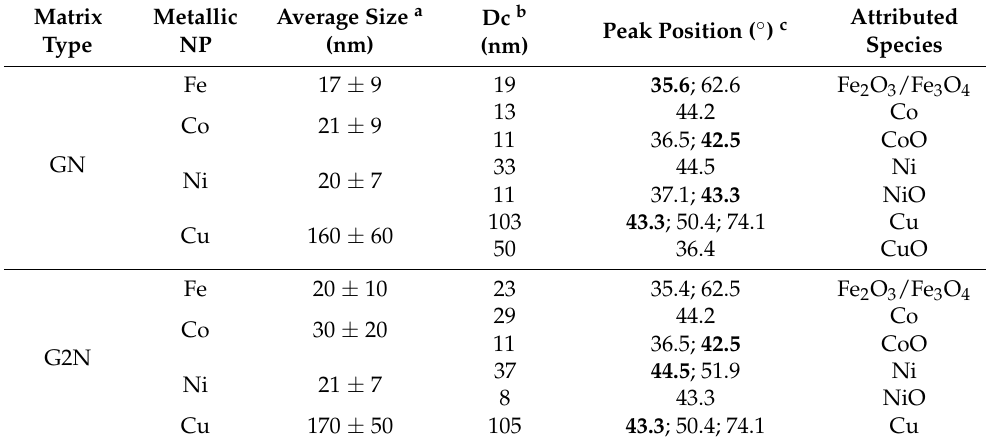
Table 2. Crystallographic parameters of the NPs obtained by XRPD of the free matrixes.